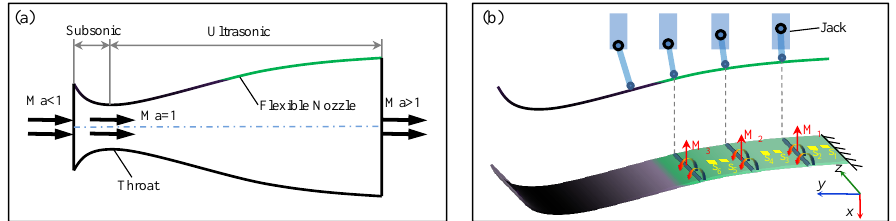
Figure 1. ( a ) Schematics of the FFN plate where Mach numbers vary from <1 to >1. ( b ) The deformation mechanism of FFN plate driven by four jacks.